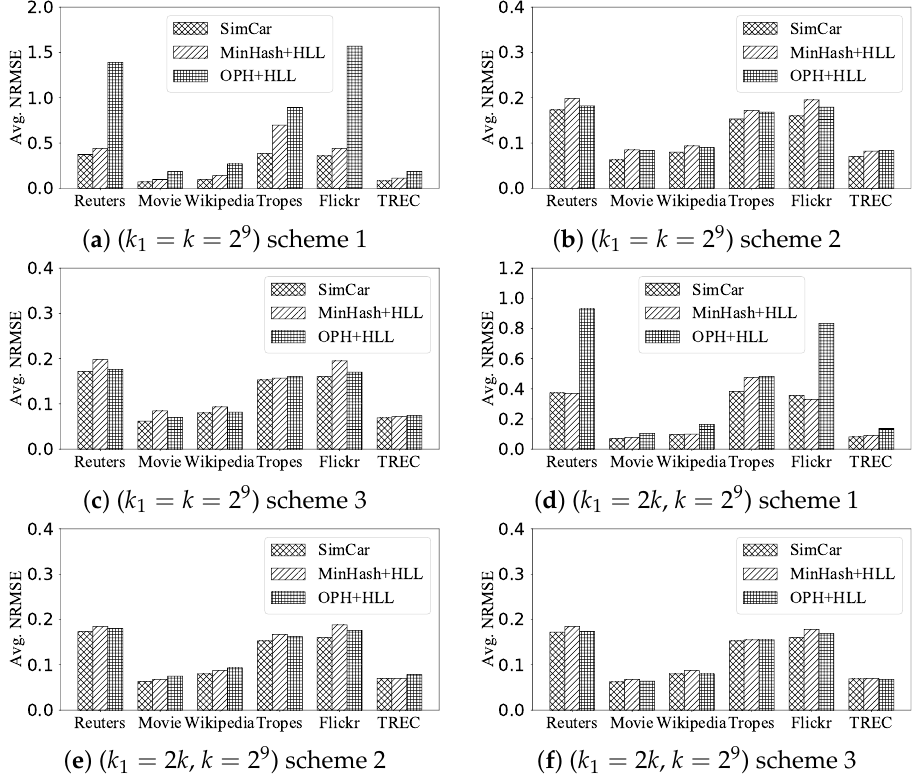
Figure 6. Average NRMSEs of SimCar compared with MinHash and HLL and OPH and HLL for estimating common-interest